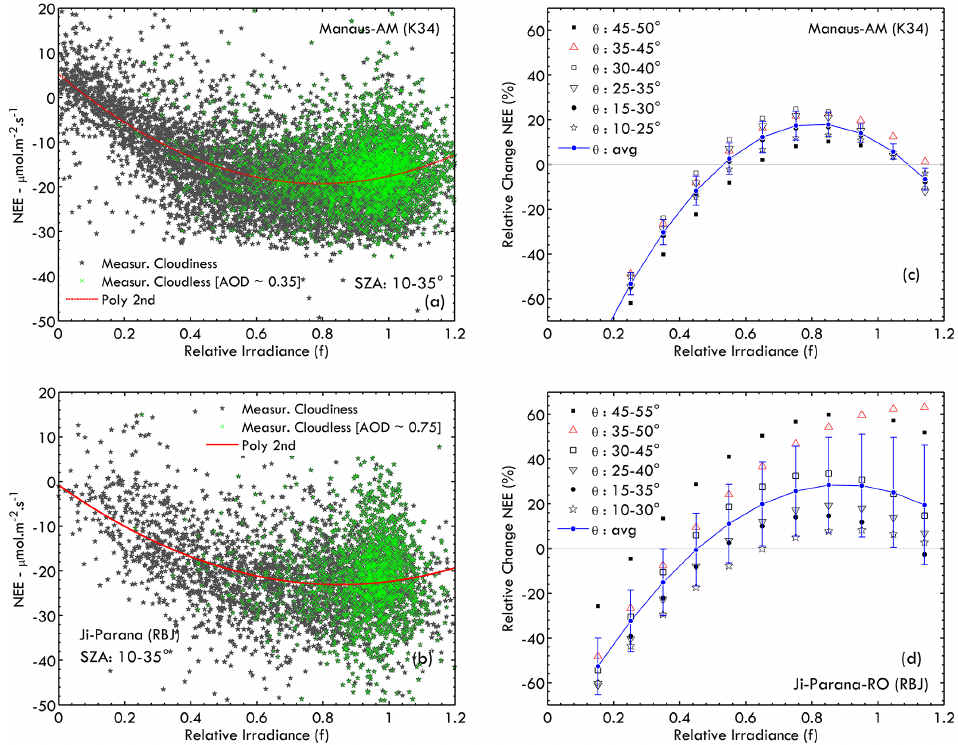
Figure 9. Variability of NEE with the relative irradiance f for the K34 /Manaus ( R 2 = 0 . 32) and RBJ/Ji-Parana ( R 2 = 0 . 12) sites for solar zenithal angle interval ( z ) between 10 ◦ and 35 ◦ – (a) and (b) . Relative change of NEE (%NEE) as a function of the relative irradiance f , averaged for all solar zenithal angle intervals ( z ), from 10 ◦ to 55 ◦ – (c) and (d) . Note that this plot includes cloud and aerosol